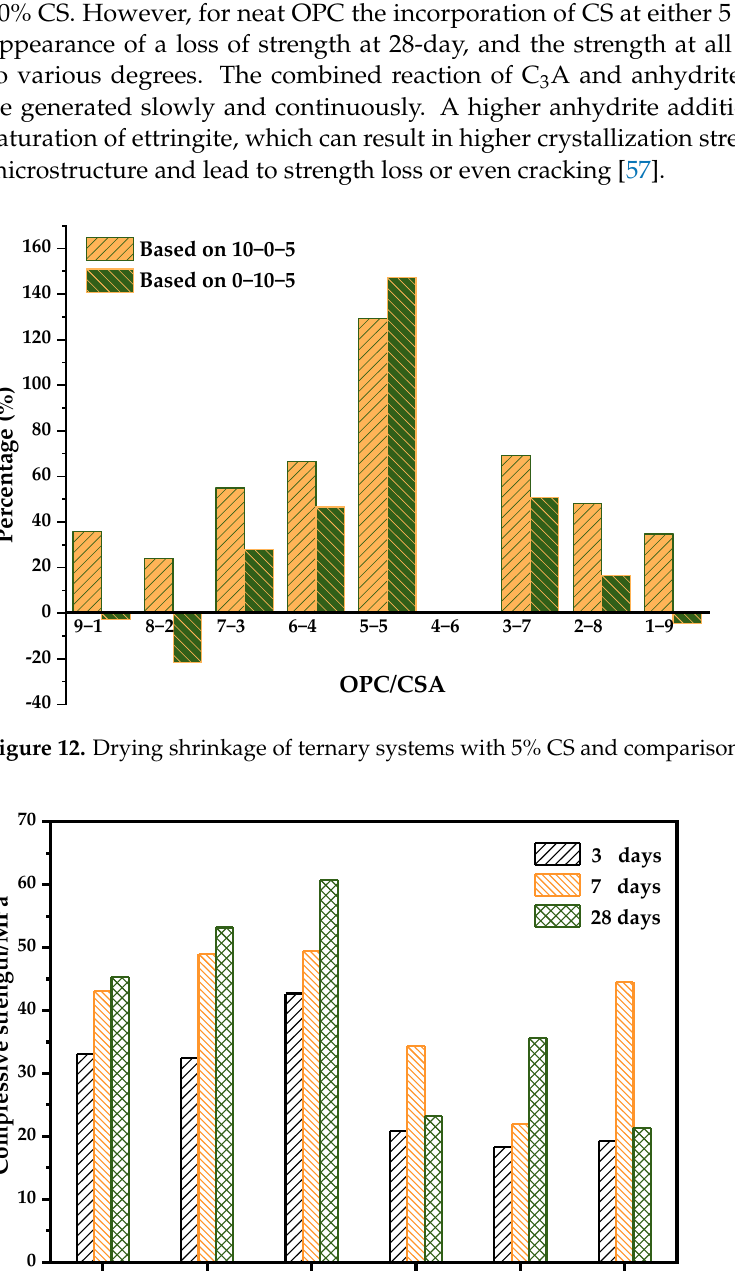
Figure 11. Effects of adding CS on the dry shrinkage of OPC-CSA binary systems.